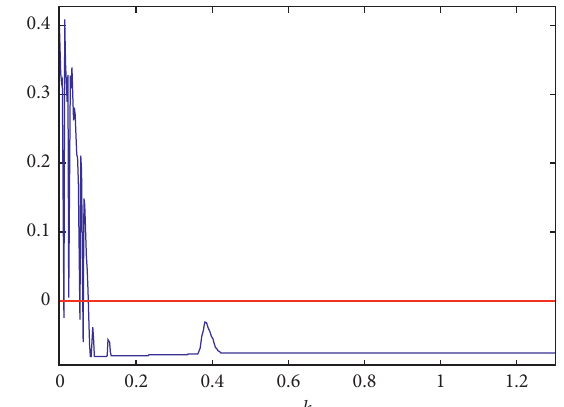
Figure 18: Maximal Lyapunov exponent with respect to k .